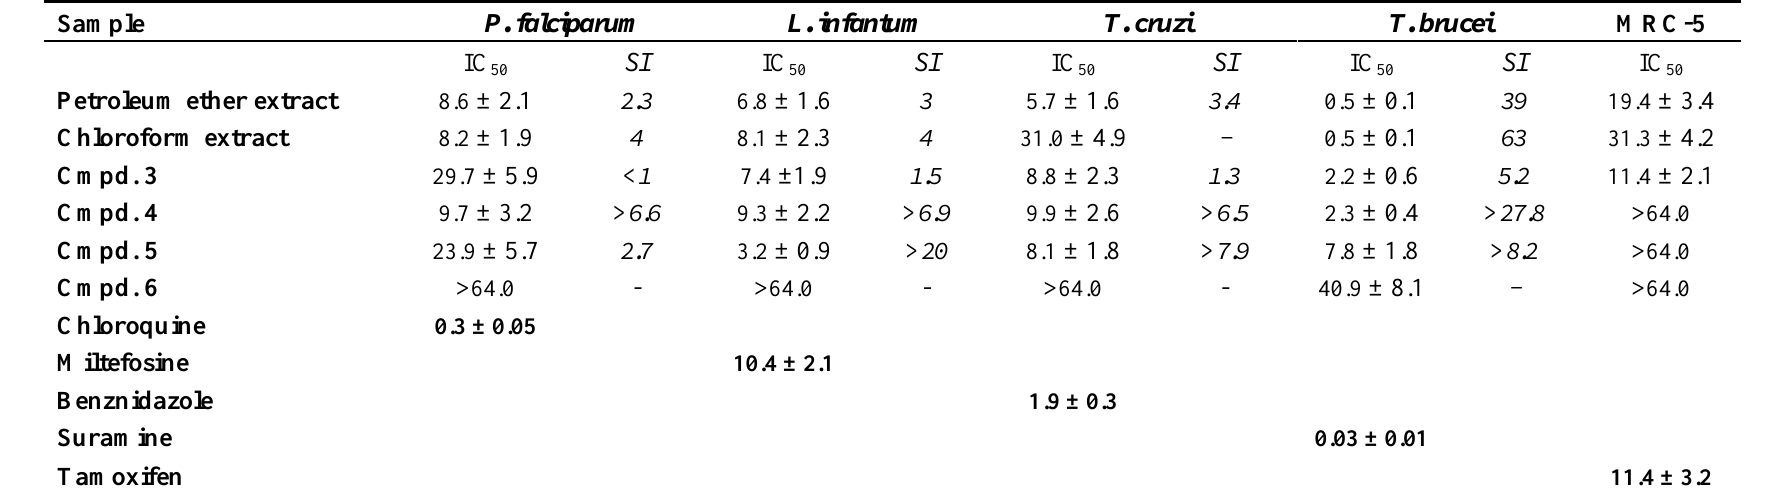
Table 2. Antiprotozoal activity and cytotoxicity of triterpenoid constituents isolated from the plant K. odora.